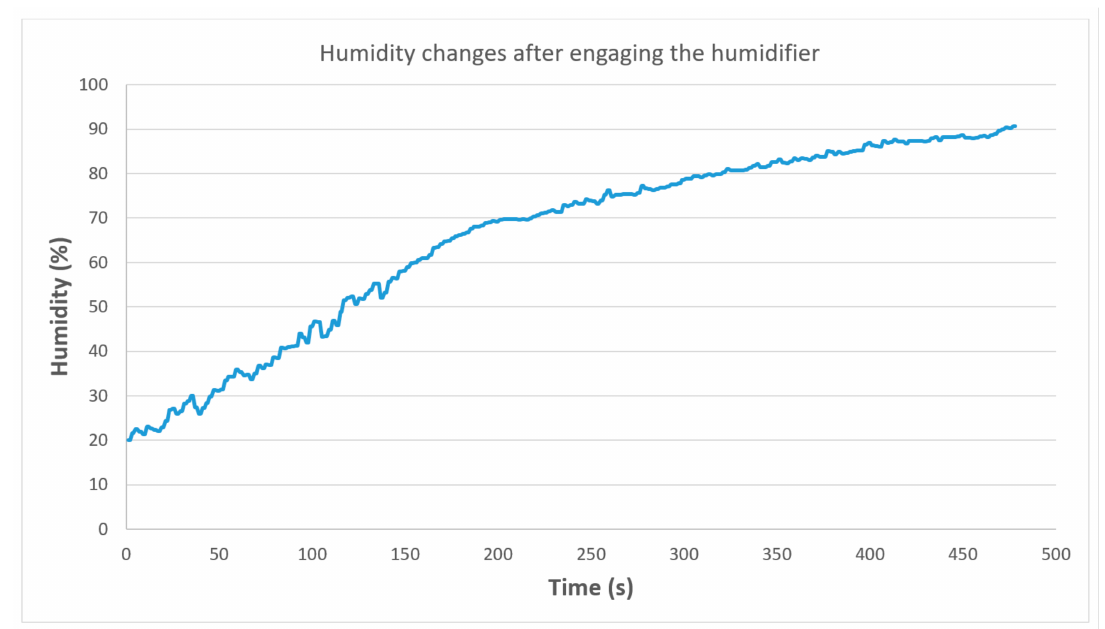
Figure 15. Plot presenting the results of the humidifying unit’s test run.